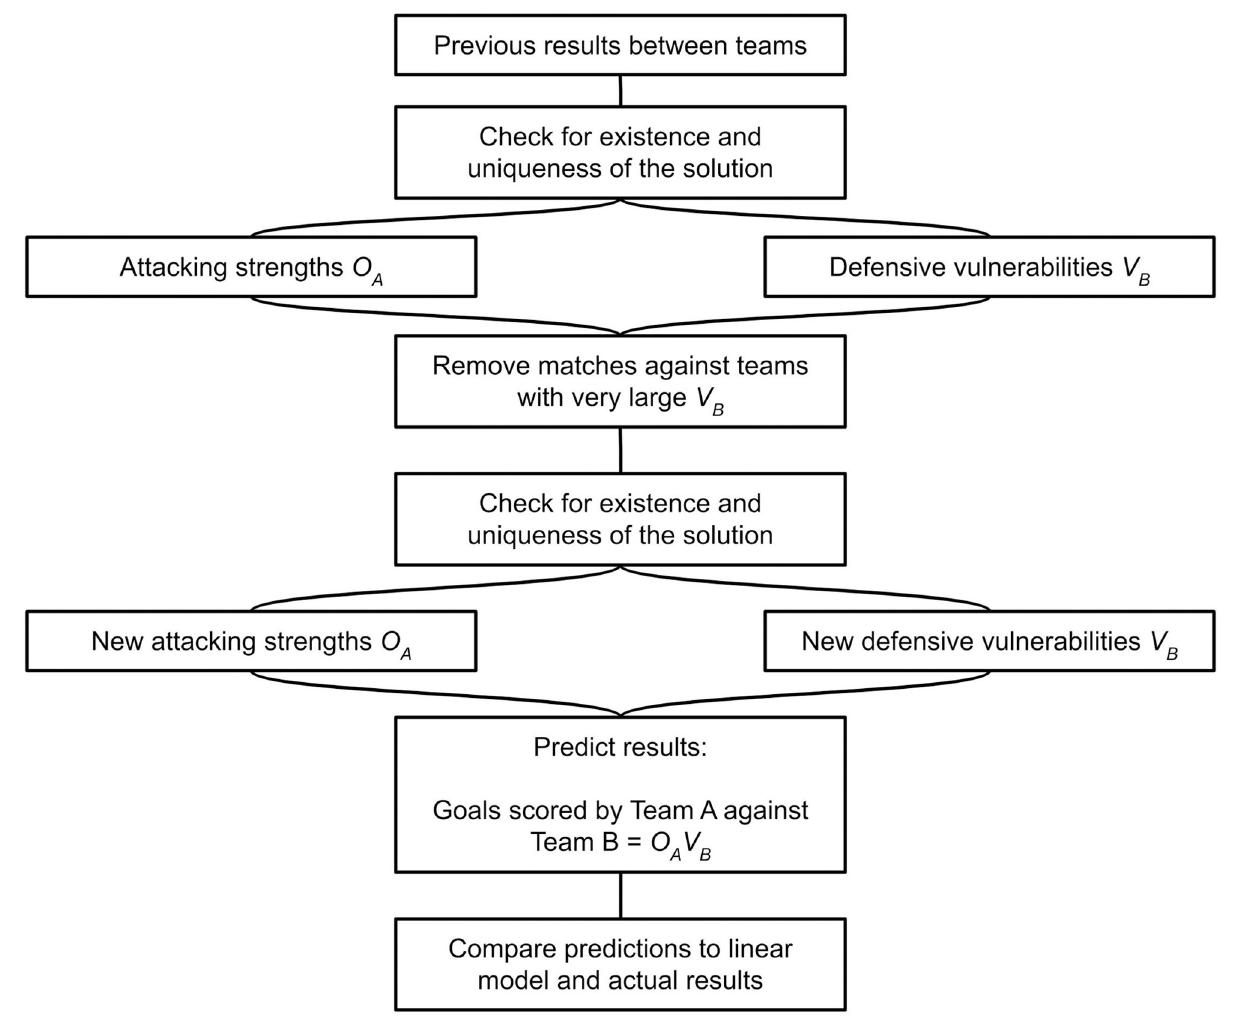
Fig 1. The general sketch of this